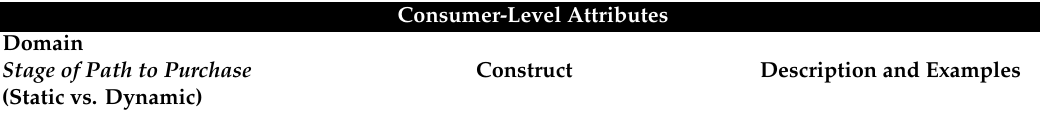
Table 1. Description of consumer- and retailer-level domains and constructs that influence consumer behavior in the online food retail environment. EBT, Electronic Benefits Transfer, GMO, genetically modified